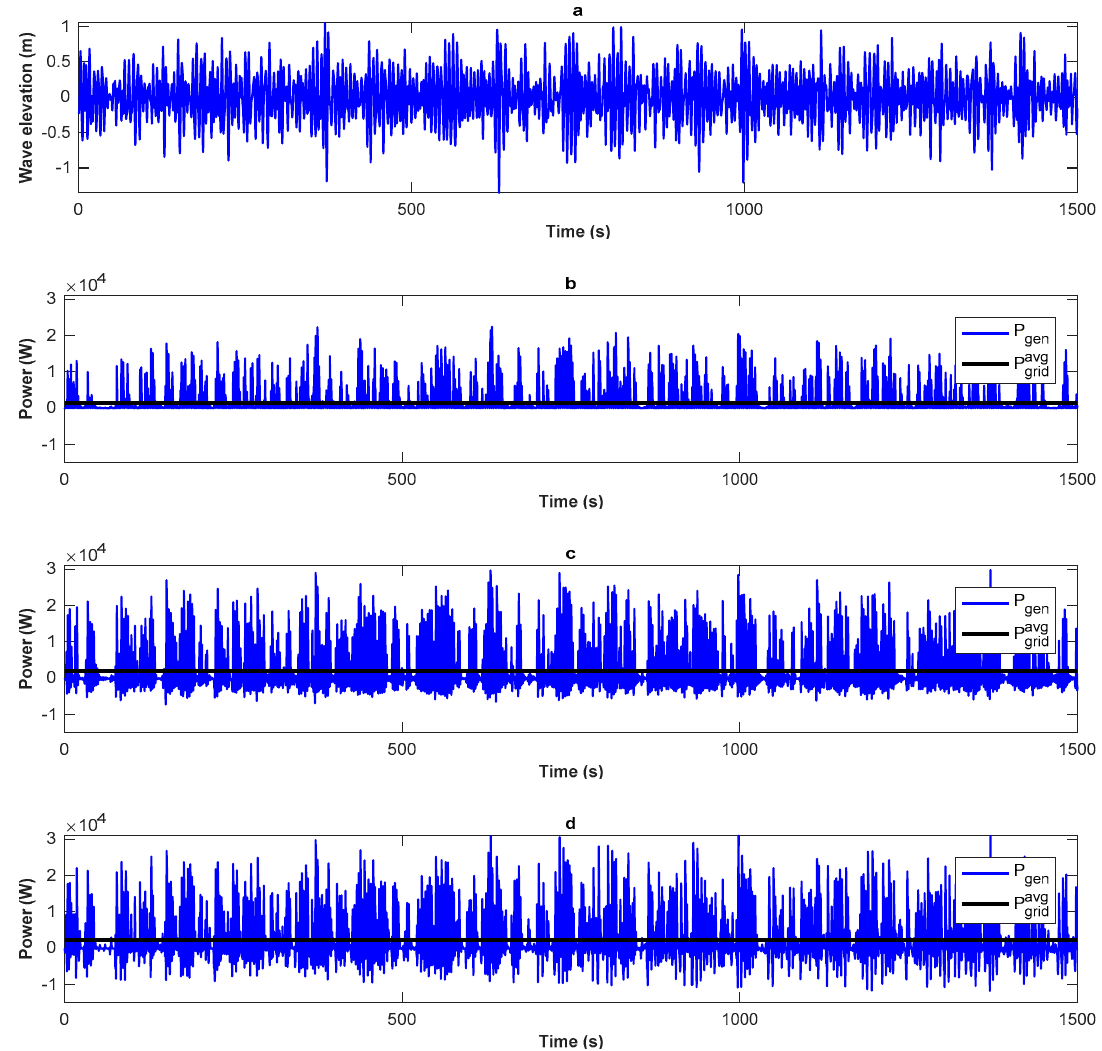
Figure 16. Results from a 1500 s simulation. ( a ) Wave resource input generated from JONSWAP spectrum with significant wave height 1.45 m and energy period 6 s; ( b ) Instantaneous generator power and averaged grid power for the RdC Gradient Descent case; ( c ) Instantaneous generator power and averaged grid power for the RsdC Gradient Descent case; ( d ) Instantaneous generator power and averaged grid power for the VelC v grid case. Table 9. Summarized results from the 1500 s random wave simulation for RdC, RsdC and VelC. Controller